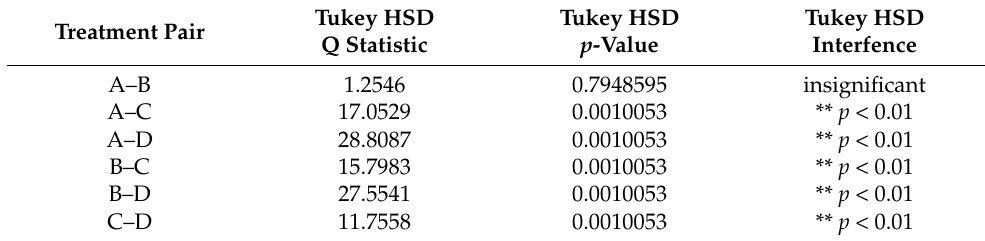
Table 3. The post-hoc Tukey HSD analysis of four group experiment.